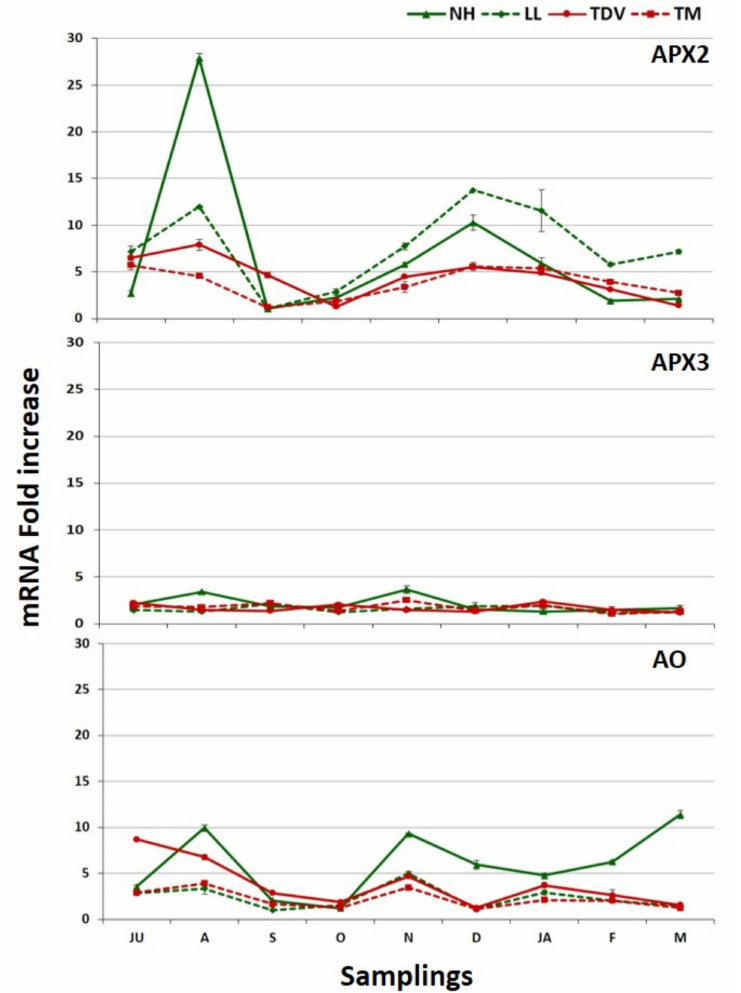
Figure 13. Real-time expression data of APX2 , APX3 , and AO genes involved in the degradation pathway in the mature leaves of Newhall (NH), Lanelate (LL), Tarocco TDV (TDV), and Tarocco Meli (TM) genotypes from July to March. The data are the mean ± S.E. of at least three